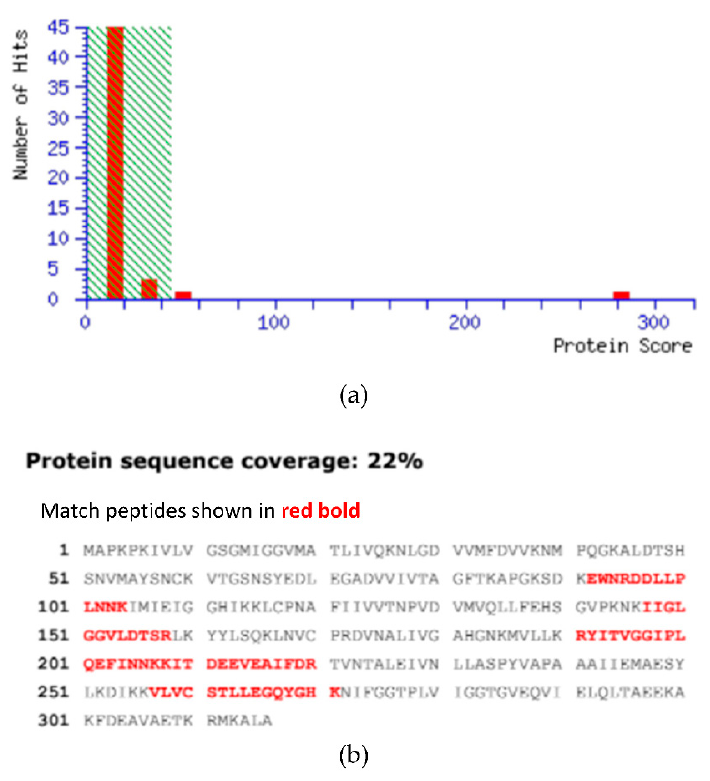
Figure 5. Mascot score histogram and protein sequence coverage of Pk -LDH. ( a ) Mascot Score His-